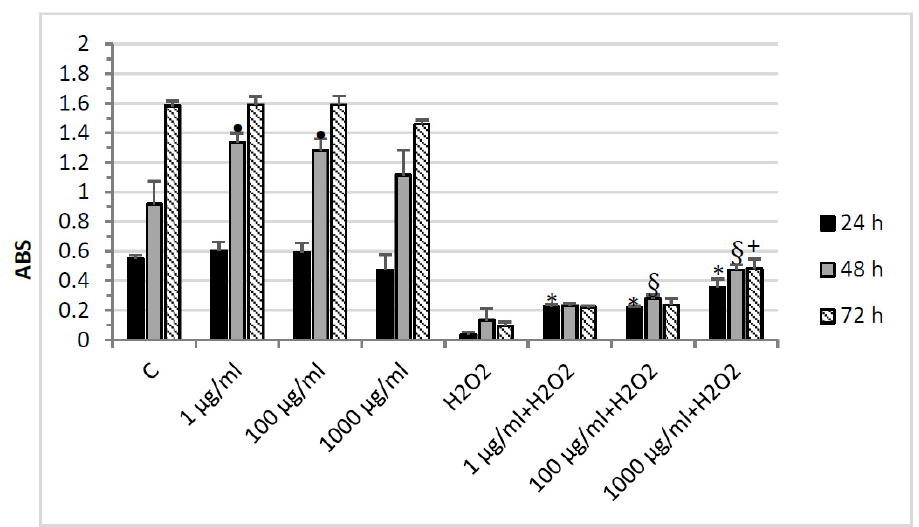
Figure 3 . MTT assay of HypoE22 hypothalamic cell line exposed to different concentrations (1– 1000 µg/mL) of water pomace extract for 24, 48, and 72 h. The data graph bars are the mean ± SD ( n = 3). • p < 0.05 vs. 48 h C; * p < 0.05 vs. 24 h H 2 O 2 ; § p < 0.05 vs. 48 h H 2 O 2 ; + p < 0.05 vs. 72 h H 2 O 2.